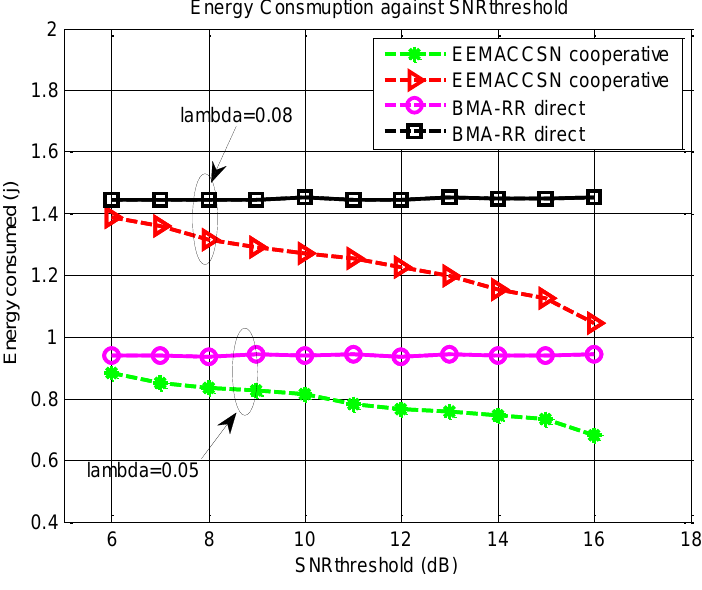
Figure 12. Energy consumption vs.